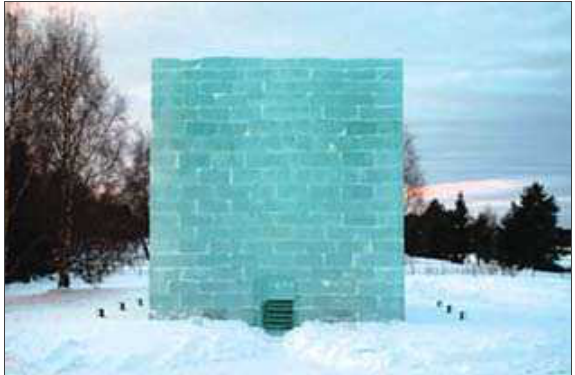
Fig. 4. Ice Installation; rovaniemi, Finland. arch. S. holl & J. highstein,